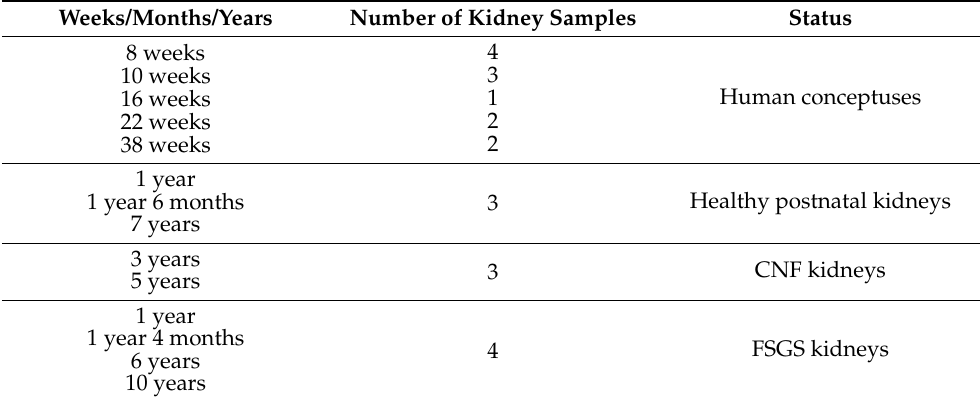
Table 2. The human kidney samples analyzed in the study.